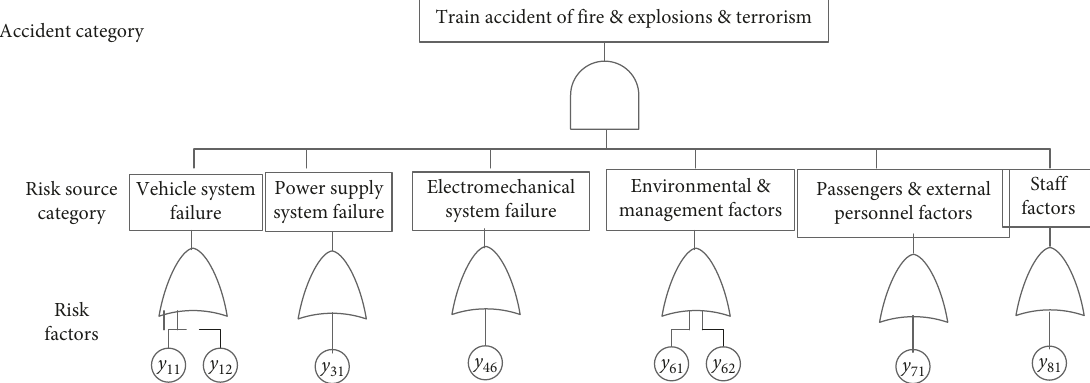
Figure 1: Fault tree analysis of fire explosions and